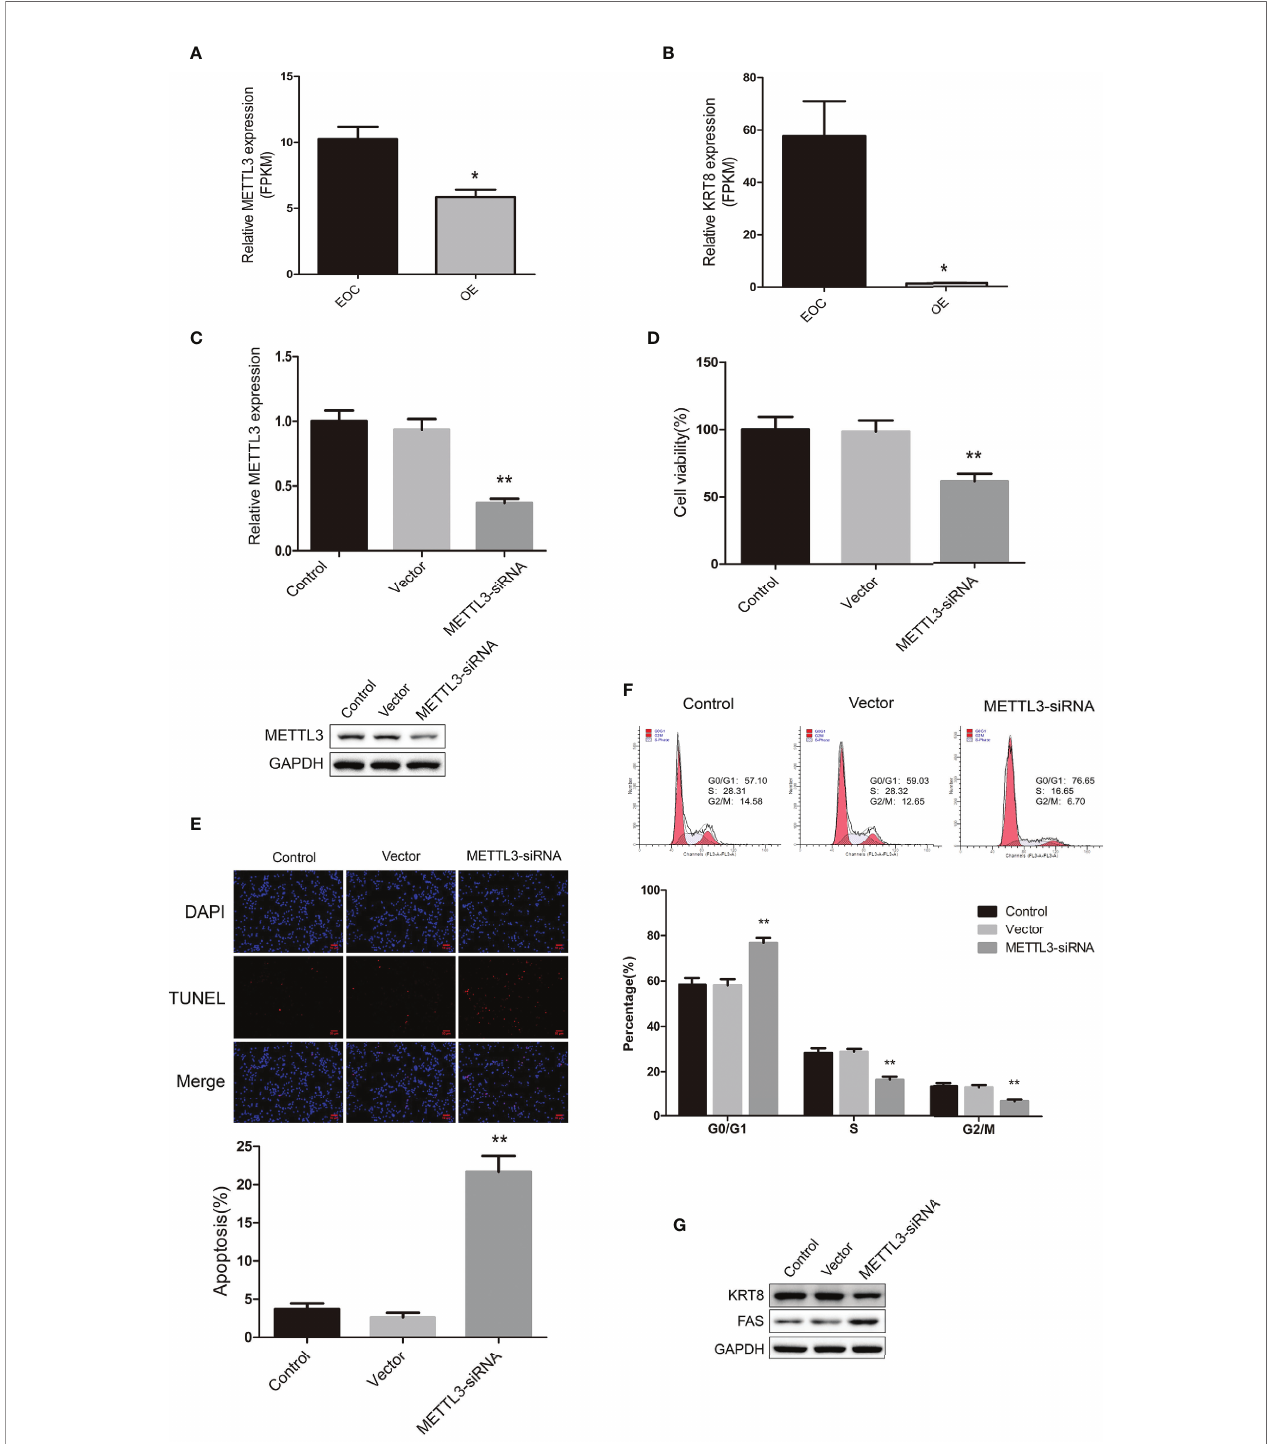
FIGURE 5 | (A) The relative mRNA expression level of METTL3 in EOC and OE groups. (B) The relative mRNA expression level of KRT8 in EOC and OE groups. (C) Real-time PCR analysis and western blot analysis for METTL3 expression in COV362 untreated cells (Control), cells transfected with empty vector (Vector), and cells transfected with METTL3-siRNA (METTL3-siRNA). (D) MTT assay showing cell viability of Control, Vector and METTL3-siRNA cells. (E) The TUNEL assay showing the apoptosis rates of Control, Vector and METTL3-siRNA cells. (F) Cell cycle analysis of Control, Vector and METTL3-siRNA cells. (G) Western blot showing the expression levels of KRT8 and FAS in Control, Vector and METTL3-siRNA cells. * P < 0.05, ** Compared with the other groups, P <